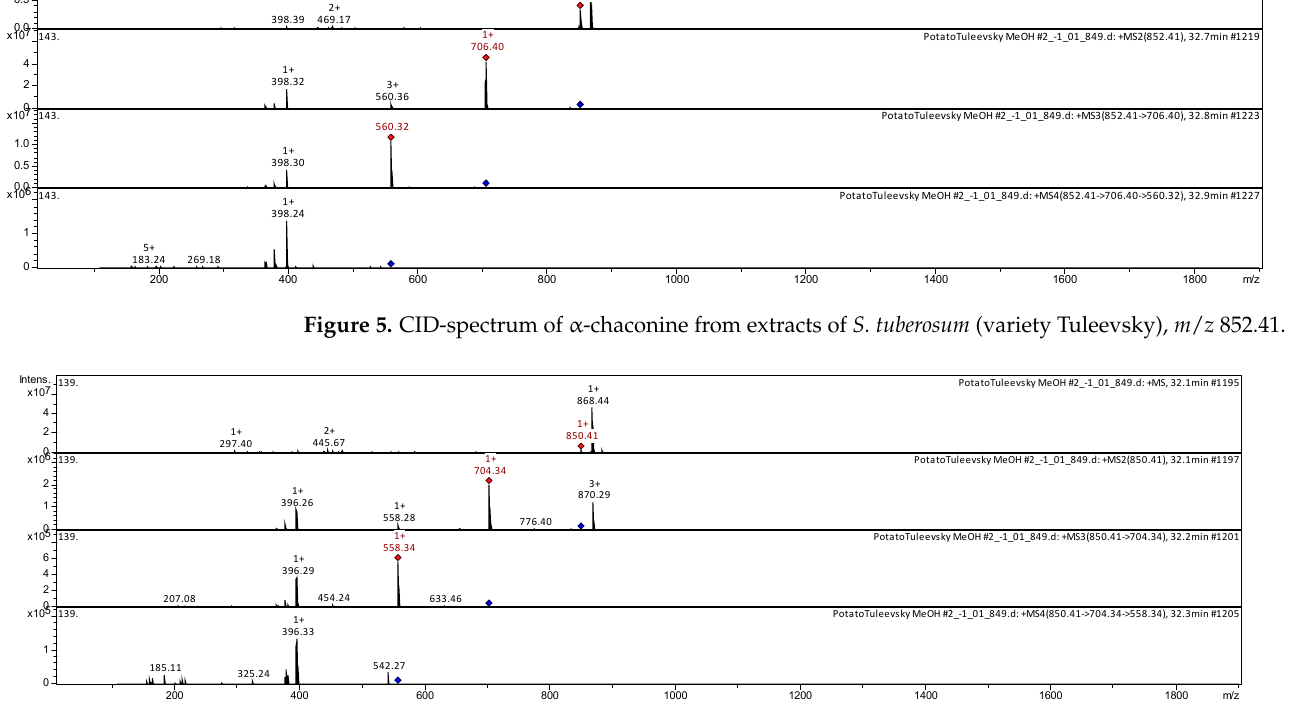
Figure 6. CID-spectrum of Dehydrochaconine [Solanidine dehydrodimer conjugated with chacotriose] from extracts of S. tuberosum (variety Tuleevsky), m / z 850.41.